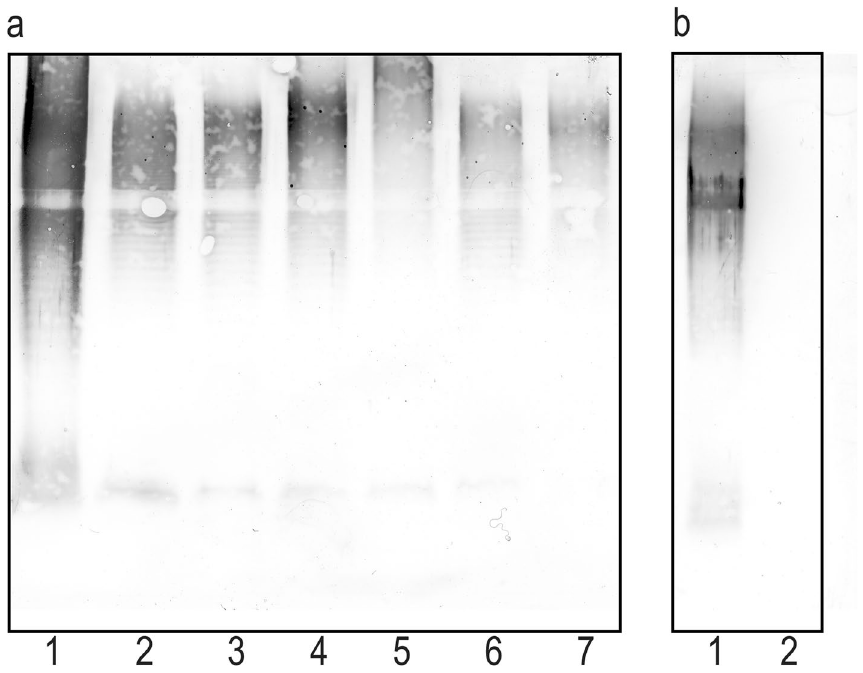
Figure 4. Western blots of O78 LPS (1) and proteinase K-treated biomasses of selected strains (2–6) classified into O78 serogroup with O78 antiserum ( a ) and O78 antiserum adsorbed by the strain 2 ( b